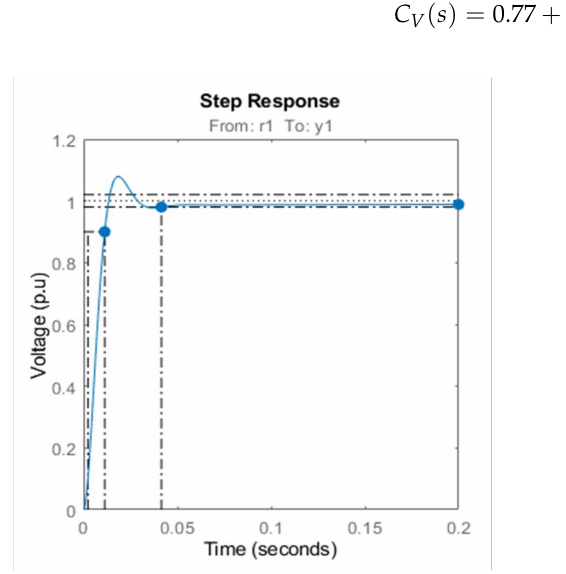
Figure 8. Step response of voltage loop.